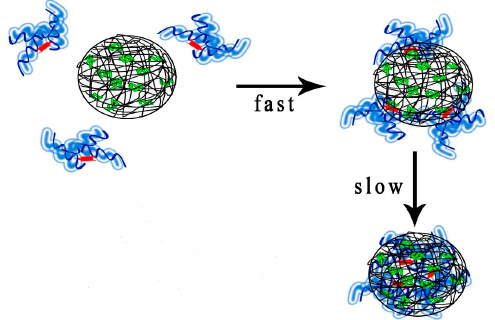
Figure 3. Sketch illustration of human serum albumin (HSA) complexation with pullulan nanoparticles.